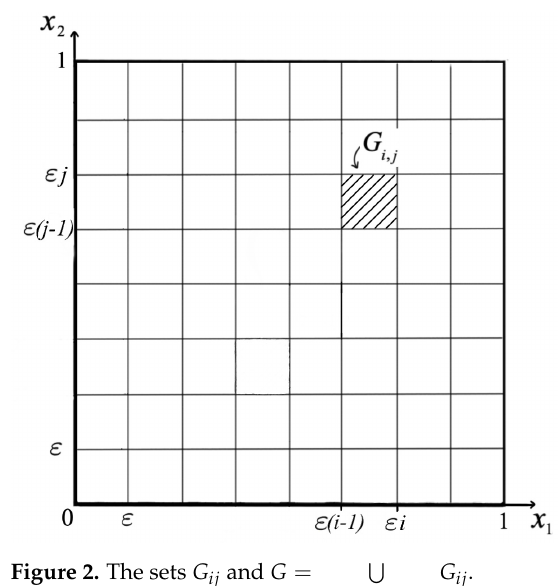
Figure 2. The sets G ij and G